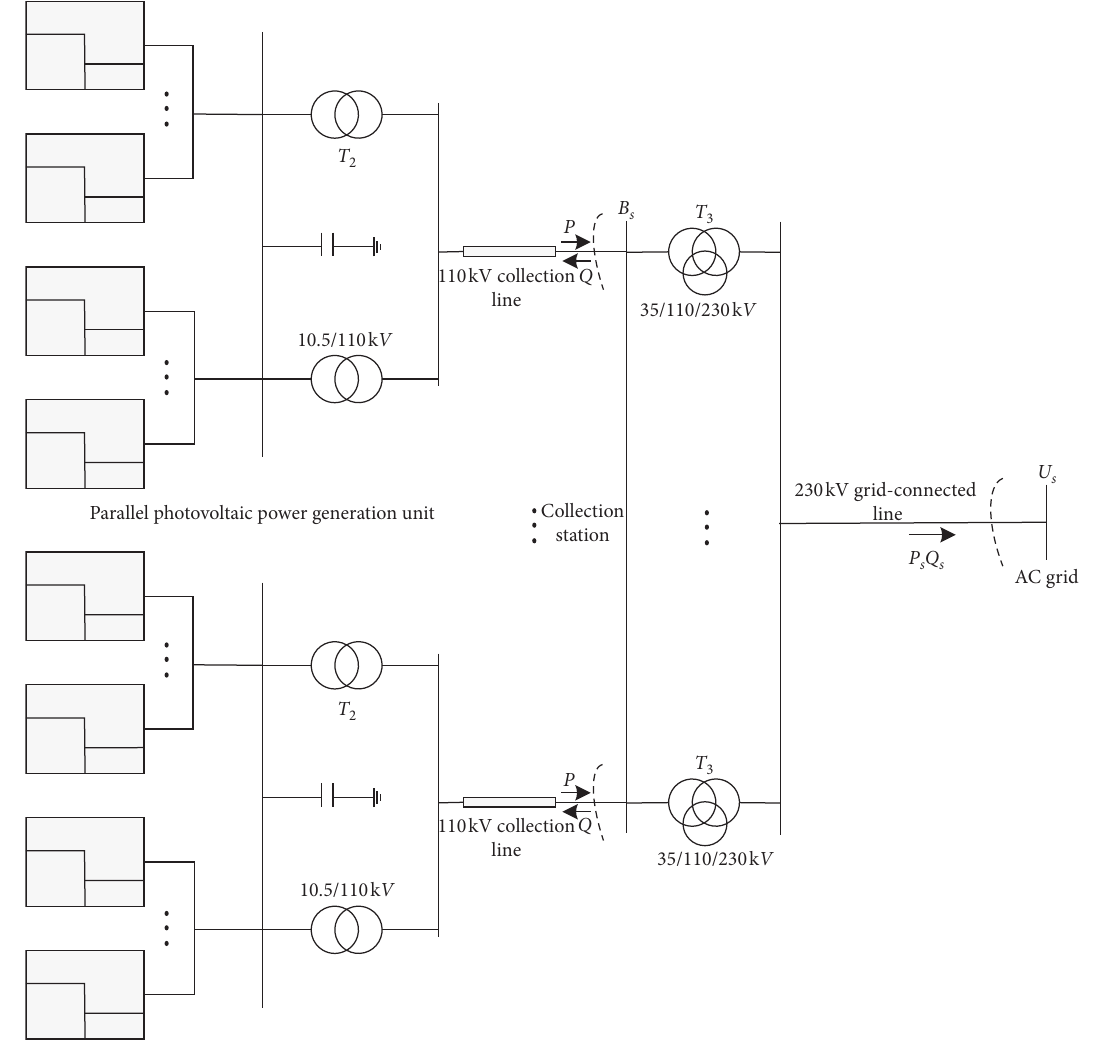
Figure 2: Photovoltaic grid-connected system